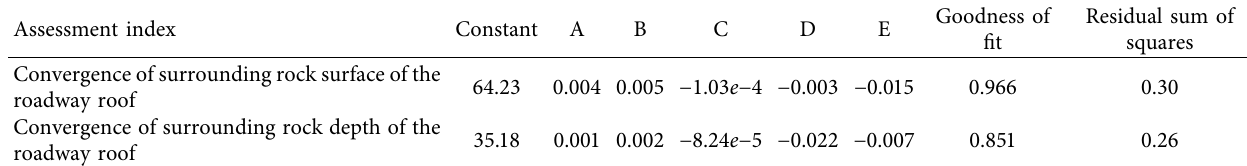
Table 5: Regression equation coefficients and reliability